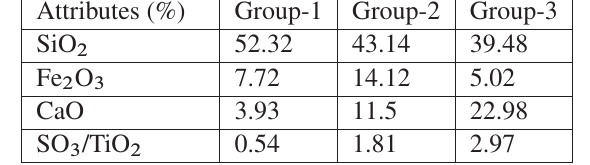
Table 7. Cluster centers by k -means algorithm.